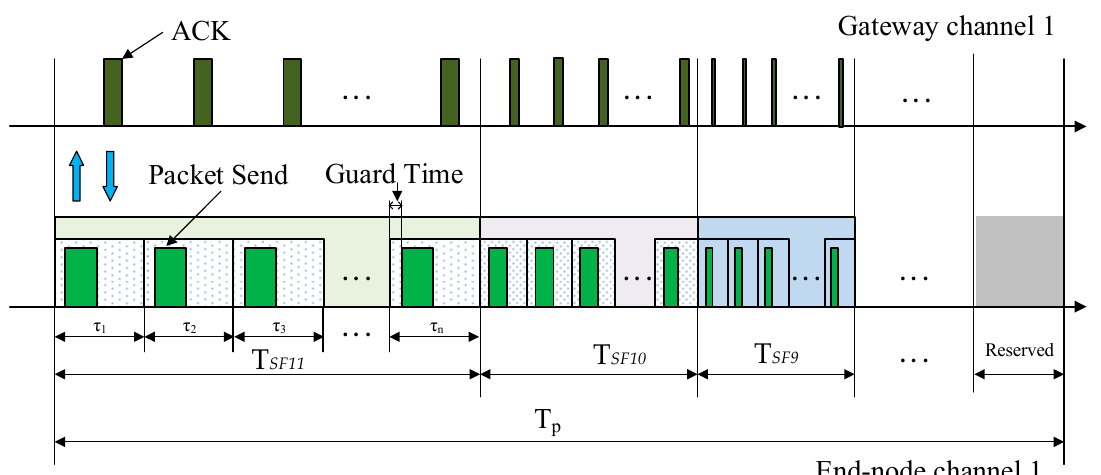
Figure 9. The channel 1 of dual-channel multiple spreading factors–time division multiple access (DMSF–TDMA).